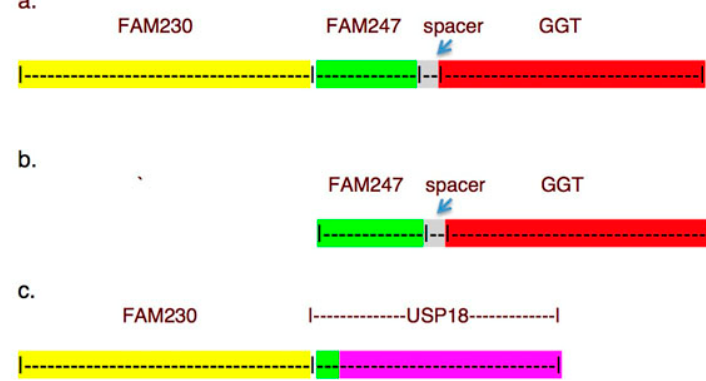
Figure 1. Schematic representation of evolutionarily conserved linked sequences with di ff erent colors Figure 1. ( a , b ) Schematic representation of evolutionarily conserved linked sequences with different depicting di ff erent sequences and family genes, as described in [9]. ( a , b ) Conserved sequences that colors depicting different sequences, as described in [9]. ( c ) The FAM247 sequence (green highlight) are found linked to GGT sequences. ( c ) The FAM247 sequence (green highlight) is embedded in the is embedded in the USP18 gene. USP18